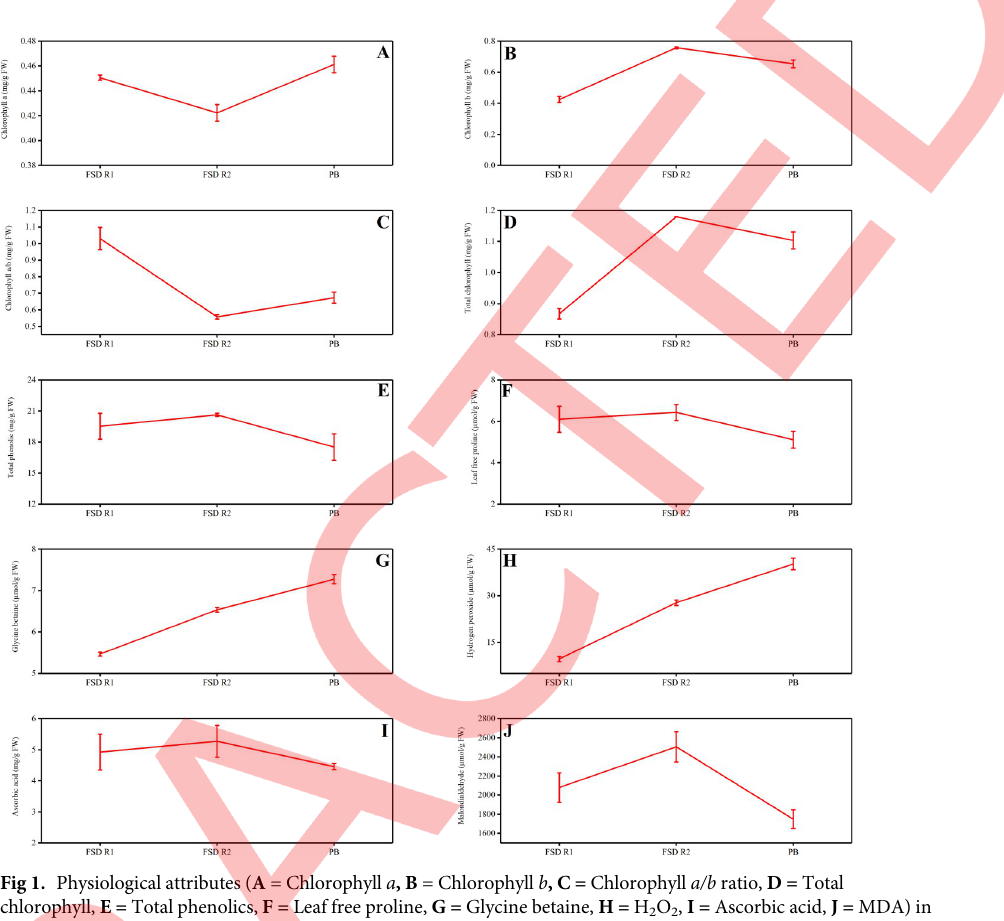
Fig 1. Physiological attributes ( A = Chlorophyll a , B = Chlorophyll b , C = Chlorophyll a/b ratio, D = Total chlorophyll, E = Total phenolics, F = Leaf free proline, G = Glycine betaine, H = H 2 O 2 , I = Ascorbic acid, J = MDA) in leaves of okra ( Abelmoschus esculentus L.) plants obtained from two regions of Faisalabad (different locations) and Pindi Bhattian.